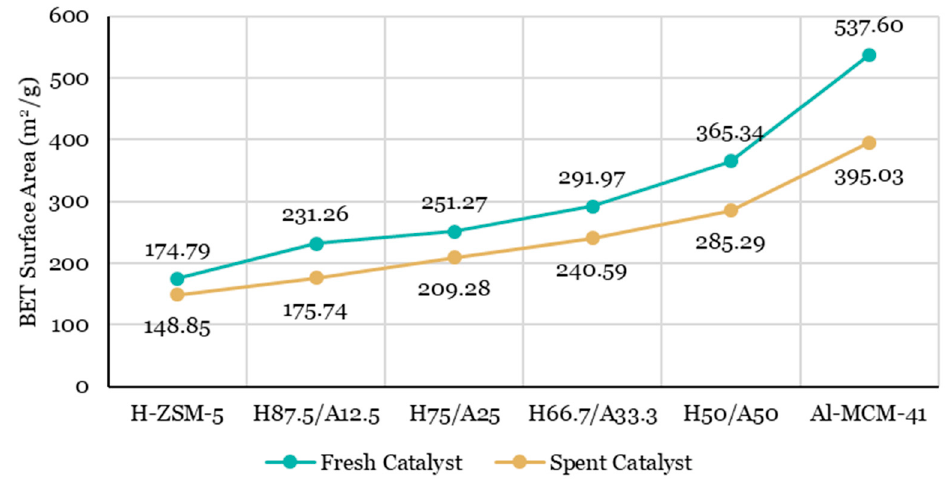
Figure 6 . The BET surface area of fresh and spent catalysts from catalytic pyrolysis of lignocellulose